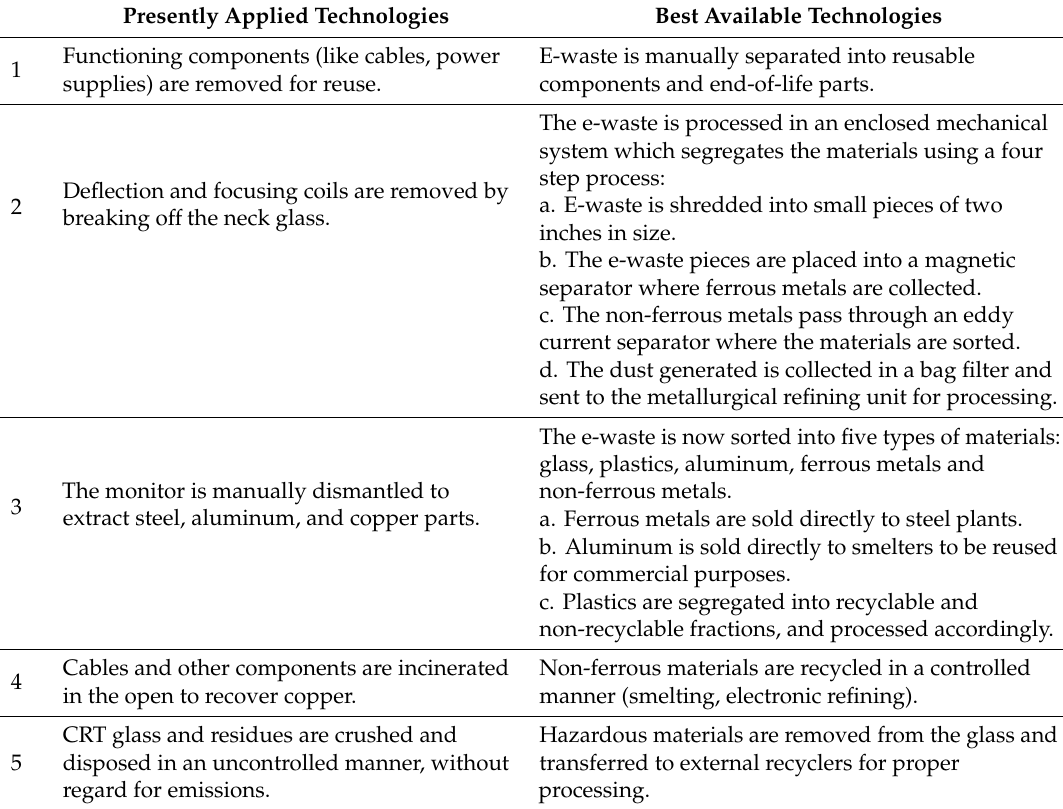
Table 1. Comparison of E-waste Recycling Processes Using Presently Applied Technologies and Best Available